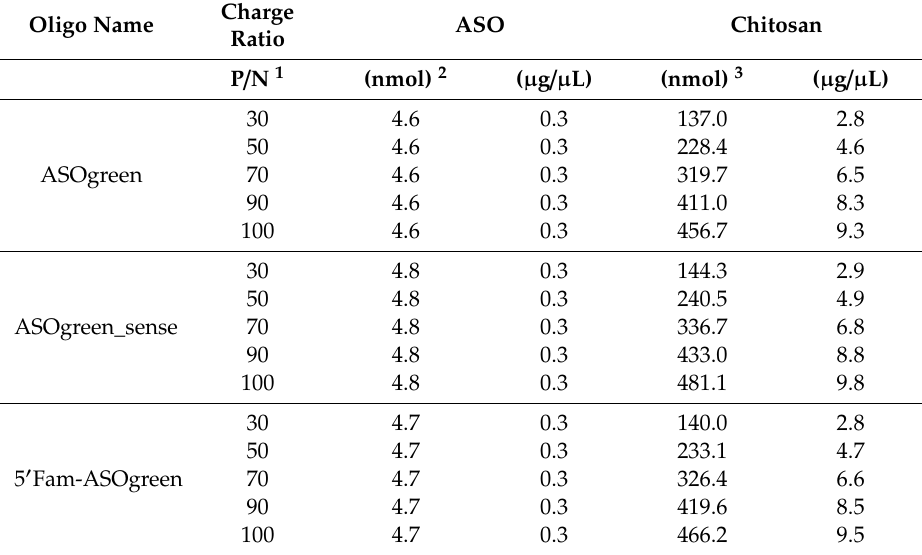
Table 2. Composition of chitosan (CS)–antisense oligonucleotide (ASO) nanocomplexes at varying positive / negative (P / N) charge